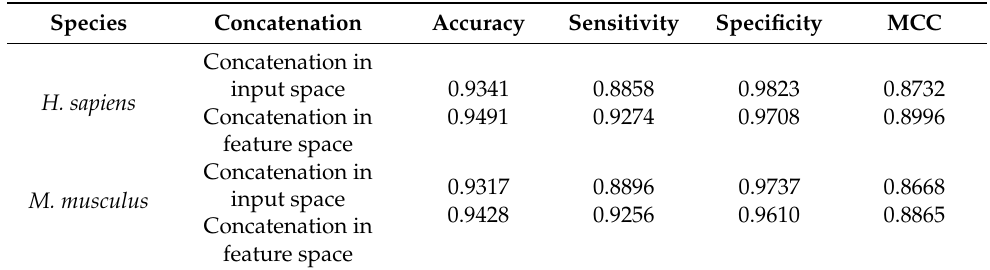
Table 4. Comparison of m6A site prediction using concatenations in input space and feature space using four species of benchmark